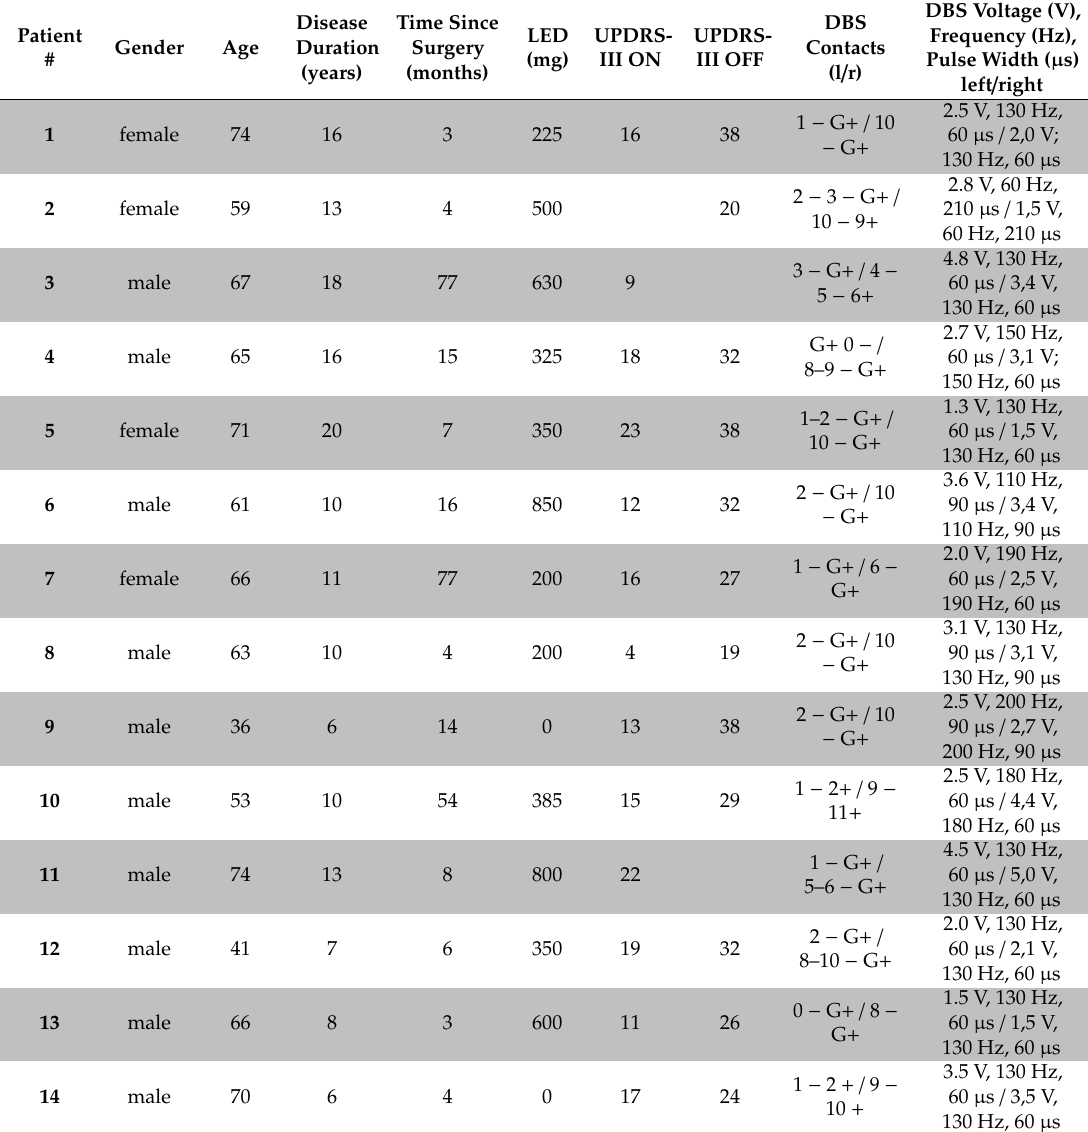
Table 1. Demographic and clinical characteristics of